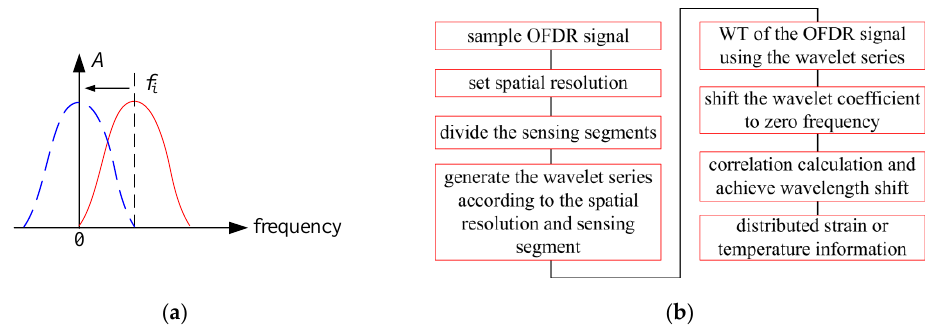
Figure 4. OFDR demodulation method based on WT. ( a ) the diagram of the wavelet equivalent BPF. ( b ) The signal processing flow of the proposed OFDR demodulation method.